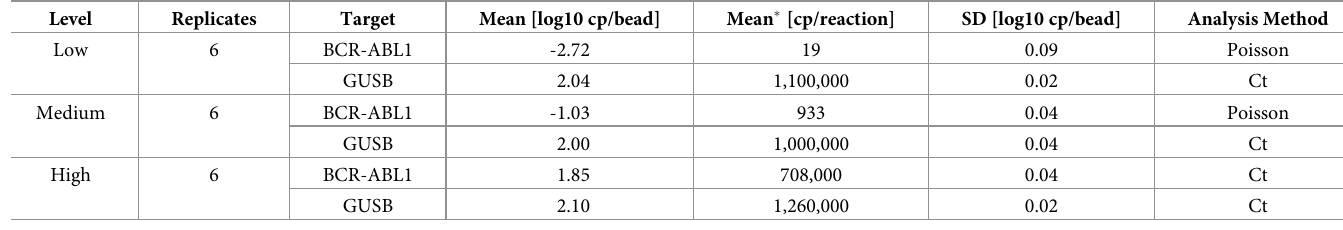
Table 2. Precision results for BCR-ABL1 and GUSB.